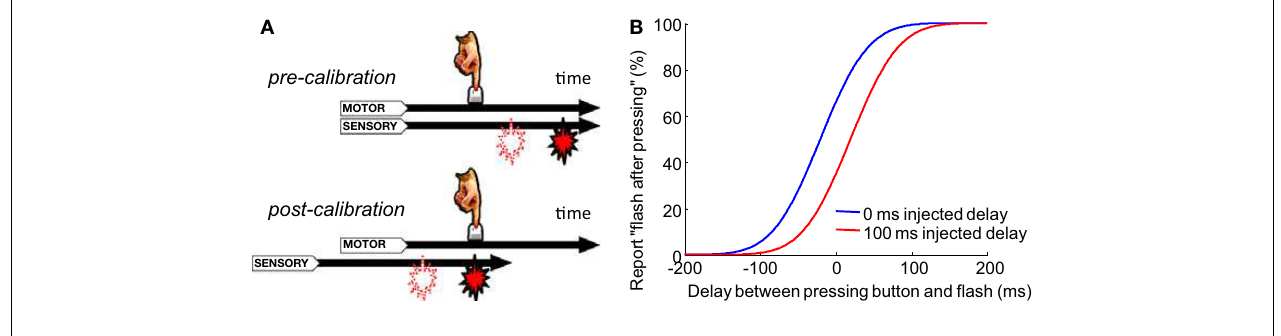
flash. In the control condition, before each test trial, participants are presented with a flash immediately after each of 3–5 presses of the button.Then, in a testing trial, they report the perceived temporal order between their press and a flash that is randomly presented before or after the press. Data from the testing trials are plotted in blue.The red curve represents the adaptation condition, in which a constant 100ms delay is injected between the flash and each of the 3–5 presses before the test trials. Curves based on average data from participants in Stetson et al.